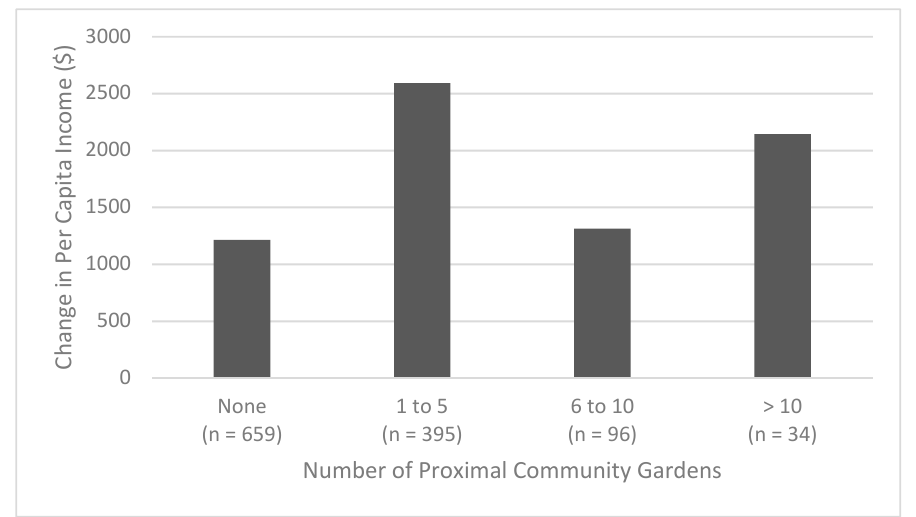
Figure 7. Population-weighted average change in per capita income (2010–2015) vs. number of community gardens proximal to lower-income block groups.